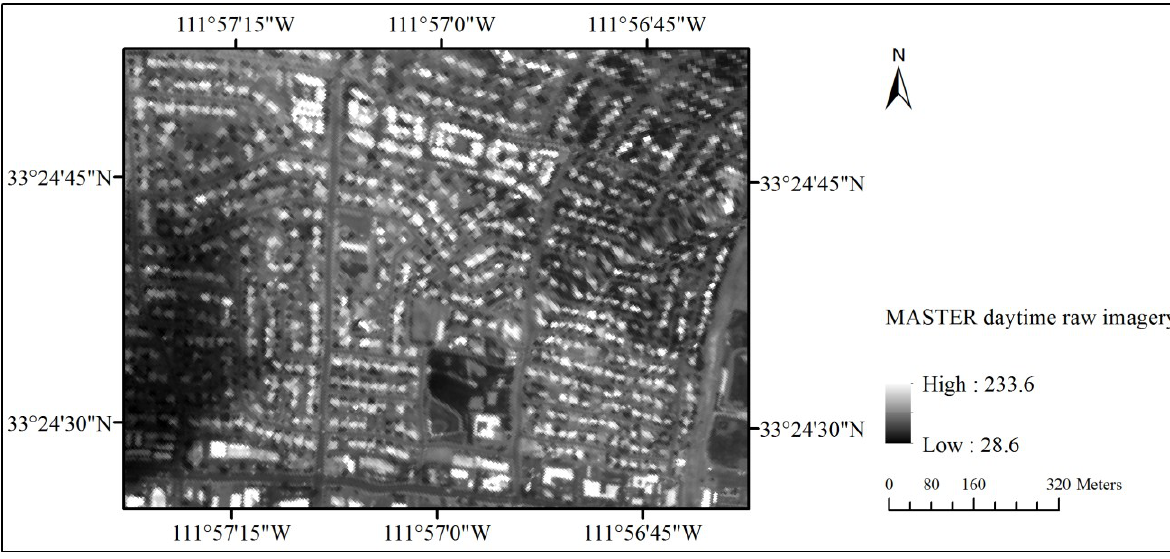
Figure 3. Raw MASTER daytime